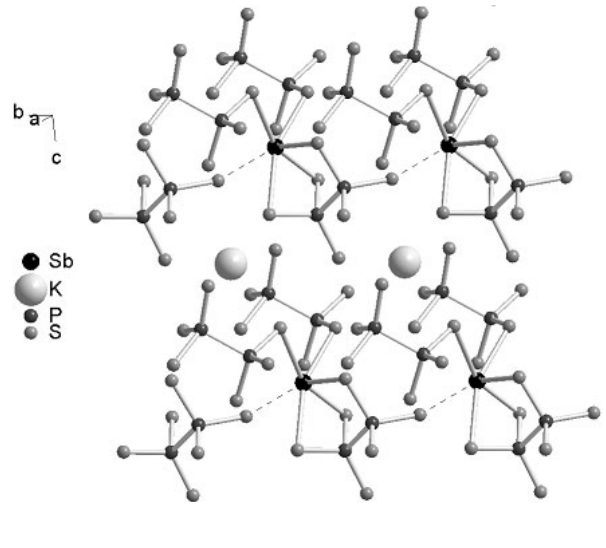
Table 1. Data collection and